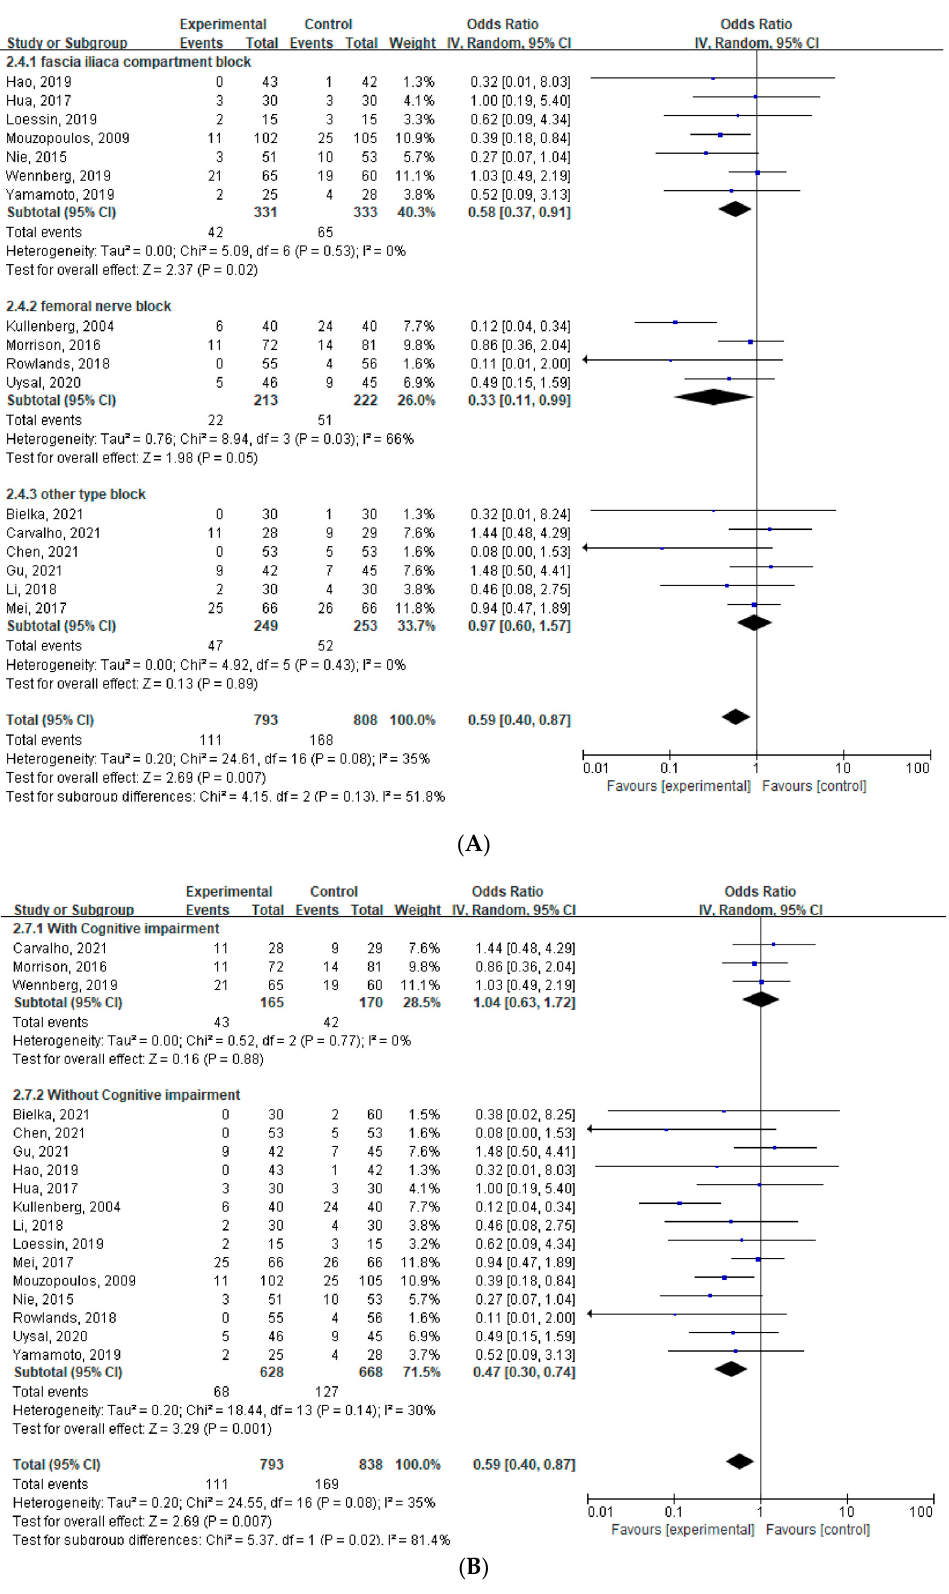
Figure 3. Forest plot: the effect of a peripheral nerve block on postoperative delirium at postoperative day three [16–19,28–32,34–36,38–42]. ( A ) Forest plot with subgroup analysis regarding the type of block. ( B ) Forest plot with subgroup analysis regarding underlying cognitive impairment. IV: inverse